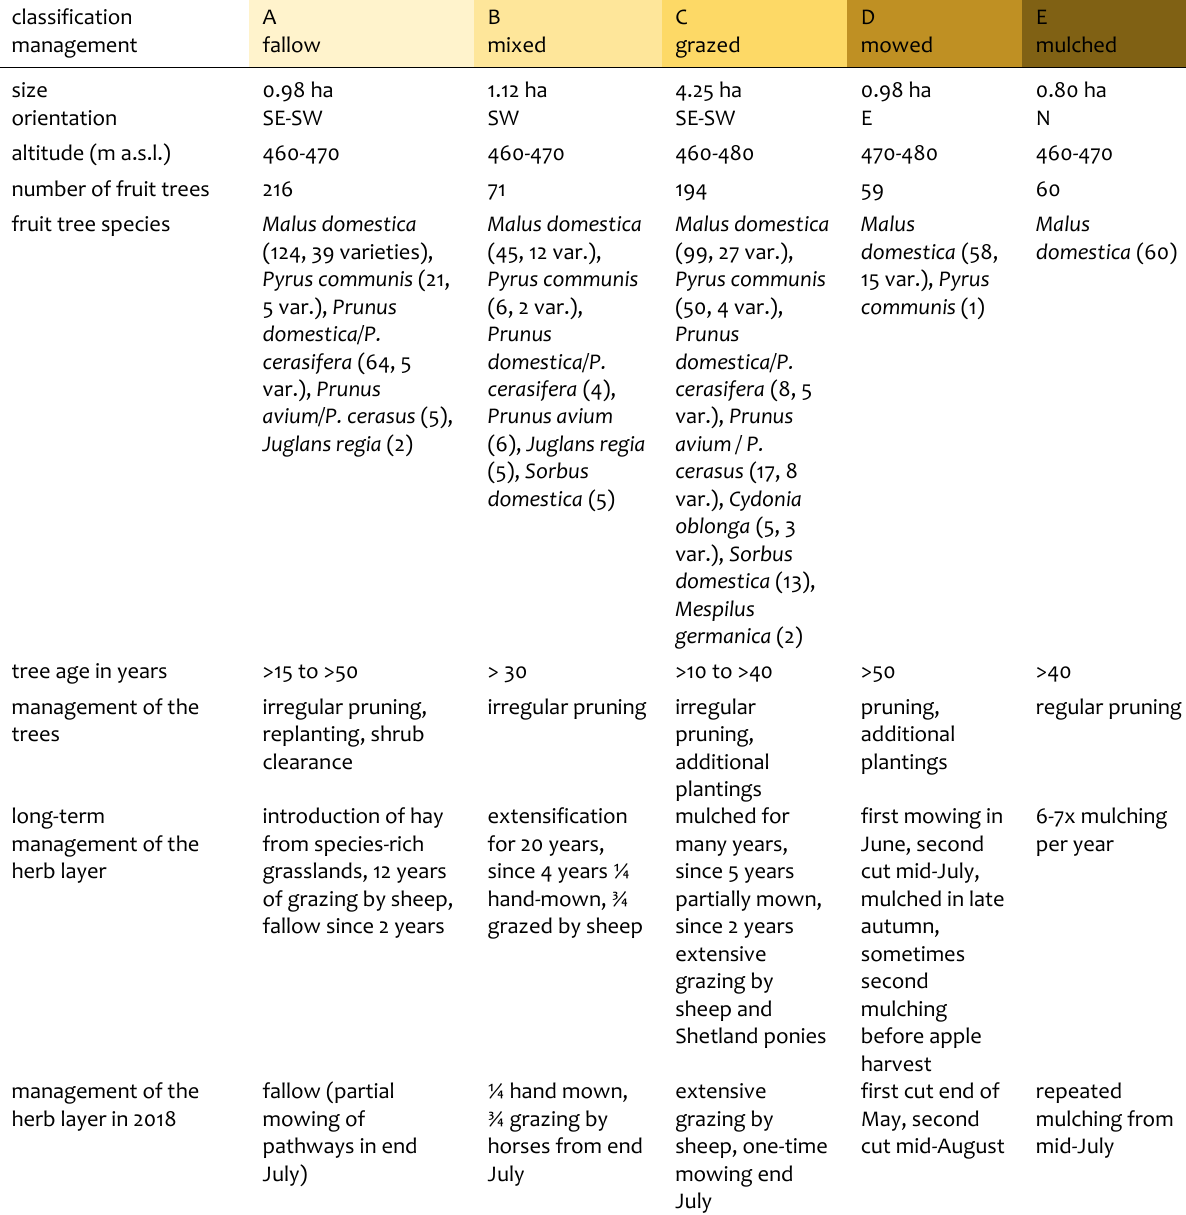
Table 1. Characteristics of the studied meadow orchards